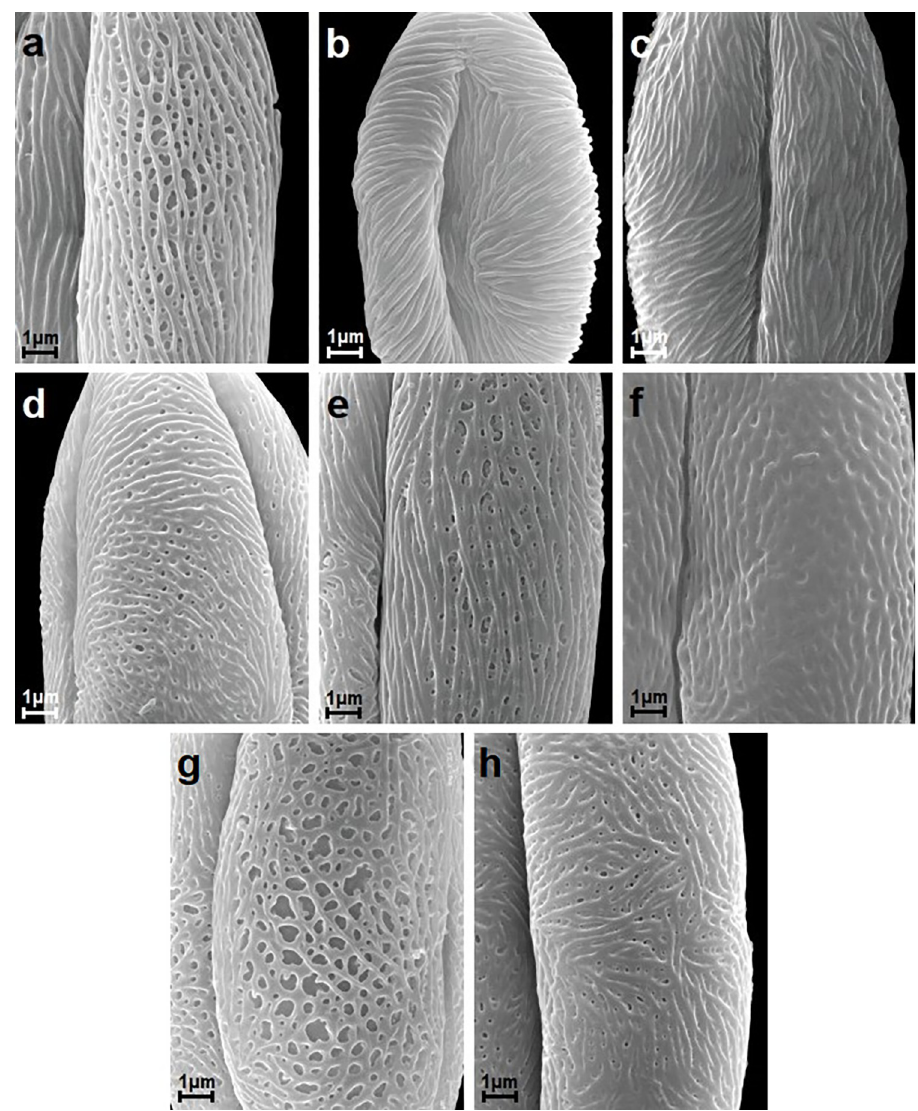
Fig 4. Striate exine ornamentation types according to Ueda and Tomita [63]; see Table 6. A-H. A, S . chinensis ; B, S . ×cinerea ‘Grefsheim’; C, S . dasyantha ; D, S . douglasii ; E, S . elegans ; F, S . henryi ; G, S . japonica ; H, S . alba var. latifolia